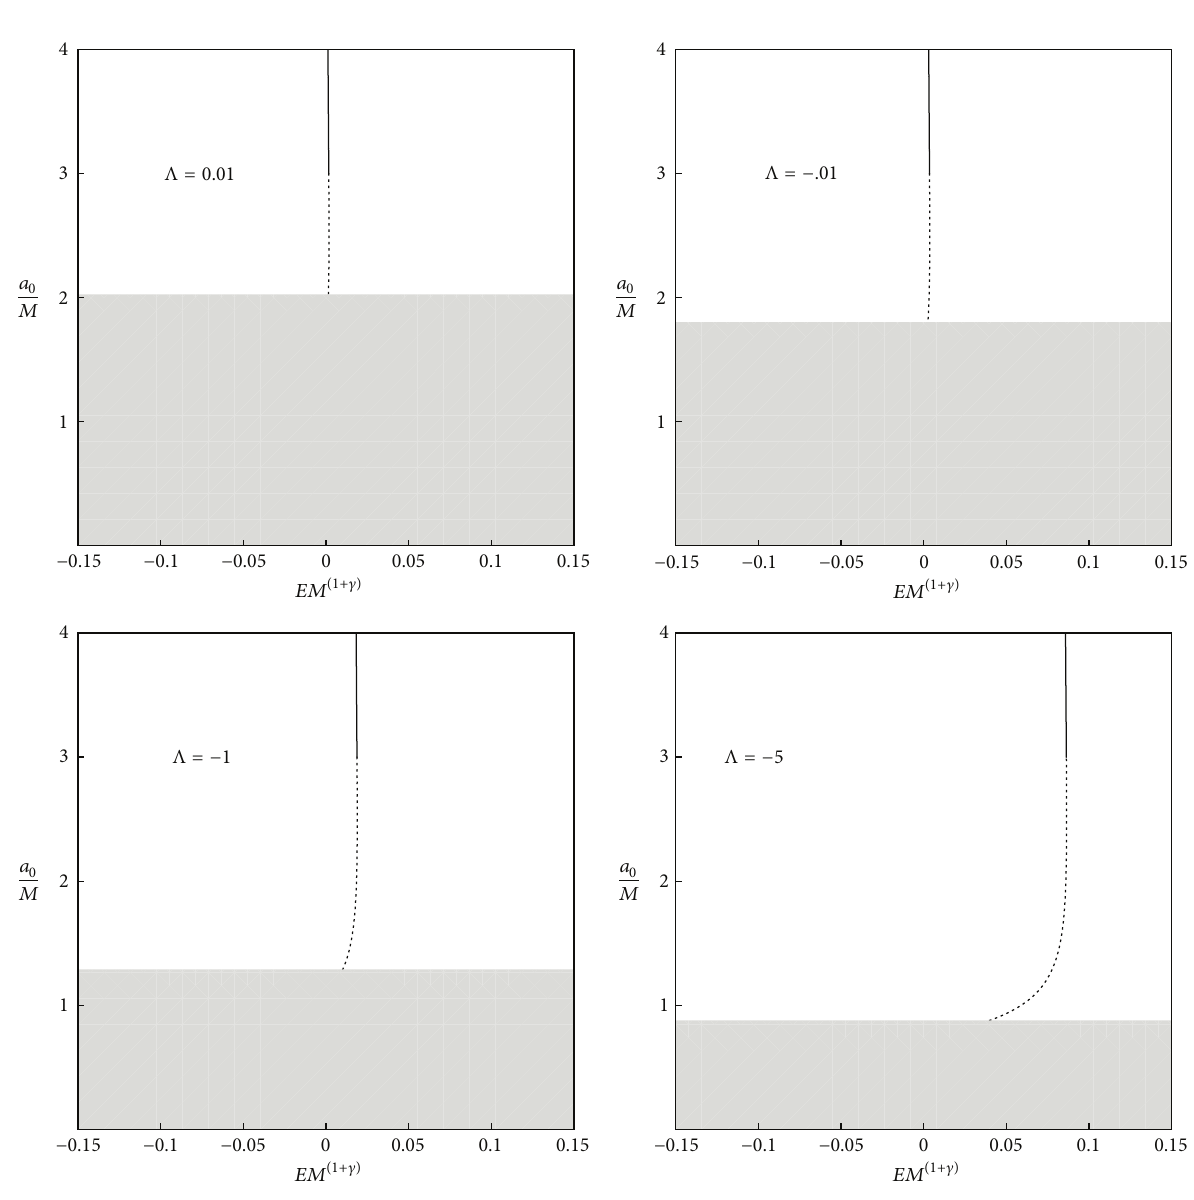
Figure 9: Plots with MCCG corresponding to 𝛾 = 1 , 𝑀 = 1 , 𝐴 = 2 , and 𝑤 = −10